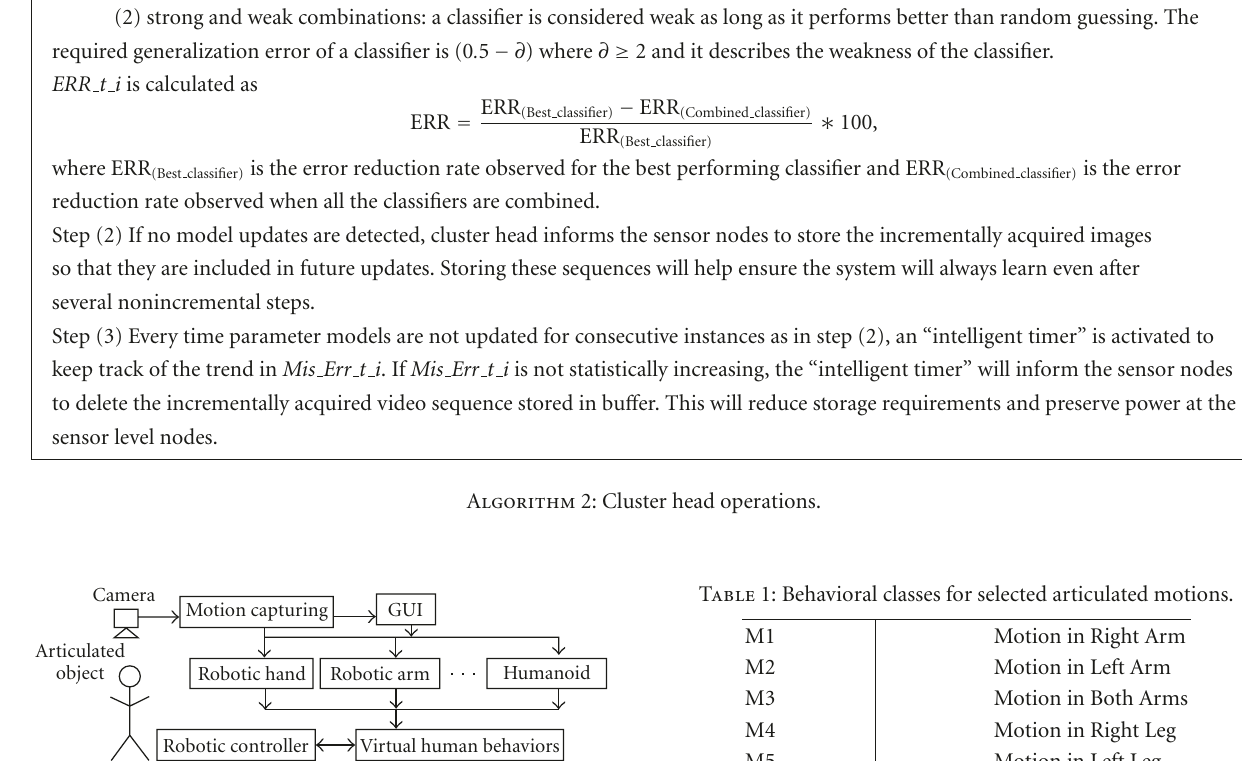
Figure 7: Learning by visual observation modules.